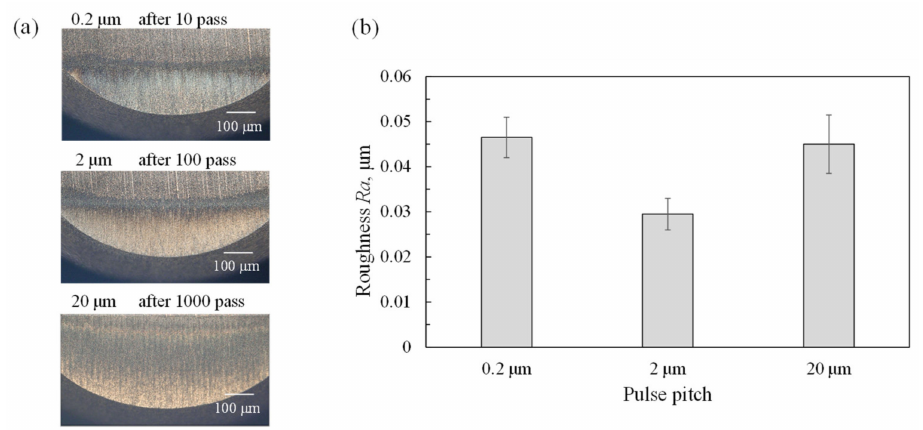
Figure 8. The PLG-processed surface at different pulse pitches of 0.2, 2, and 20 µ m after the same number of effective irradiated pulses of 1250: ( a ) Optical microscope images and ( b ) roughness Ra